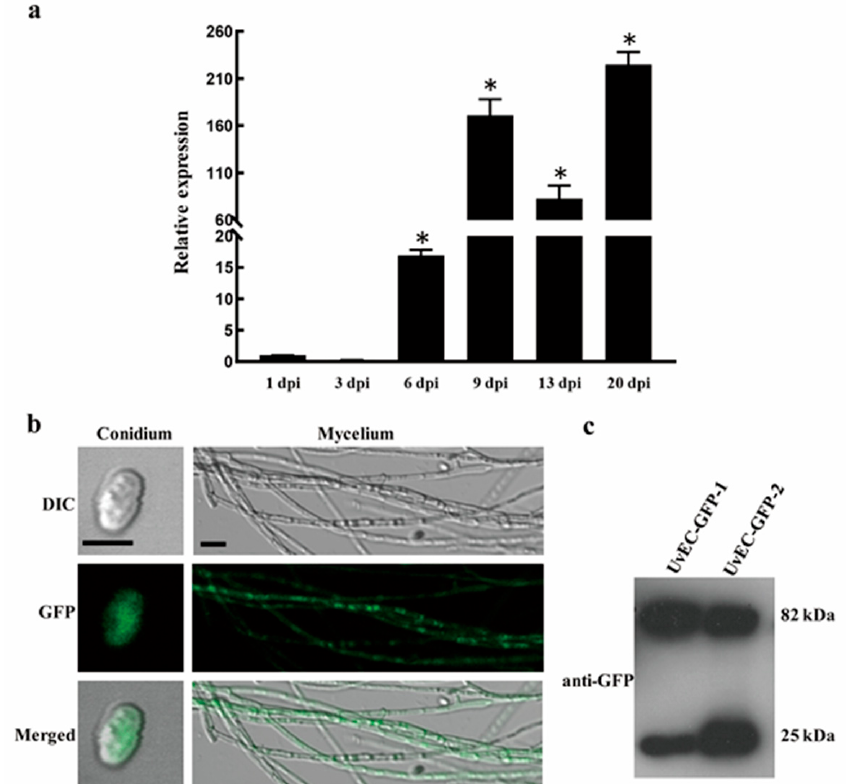
Figure 6. Expression of UvEC1 and subcellular localization of UvEC1 in U. virens. ( a ) Relative expression of UvEC1 at different infection stages on rice spikelets (1–21 d), as determined by RT-qPCR. UvEC1 expression was normalized to that of β -tubulin . Asterisks represent significant differences relative to 1 dpi by LSD at p = 0.05 ( b ) Subcellular localization of UvEC1 in U. virens . DIC, differential interference contrast; GFP, green fluorescent protein. Scale bars = 10 µ m. ( c ) Immunoblot analysis of UvEC1-GFP-CDC11 in the C ∆ UvEC1-1 strain.